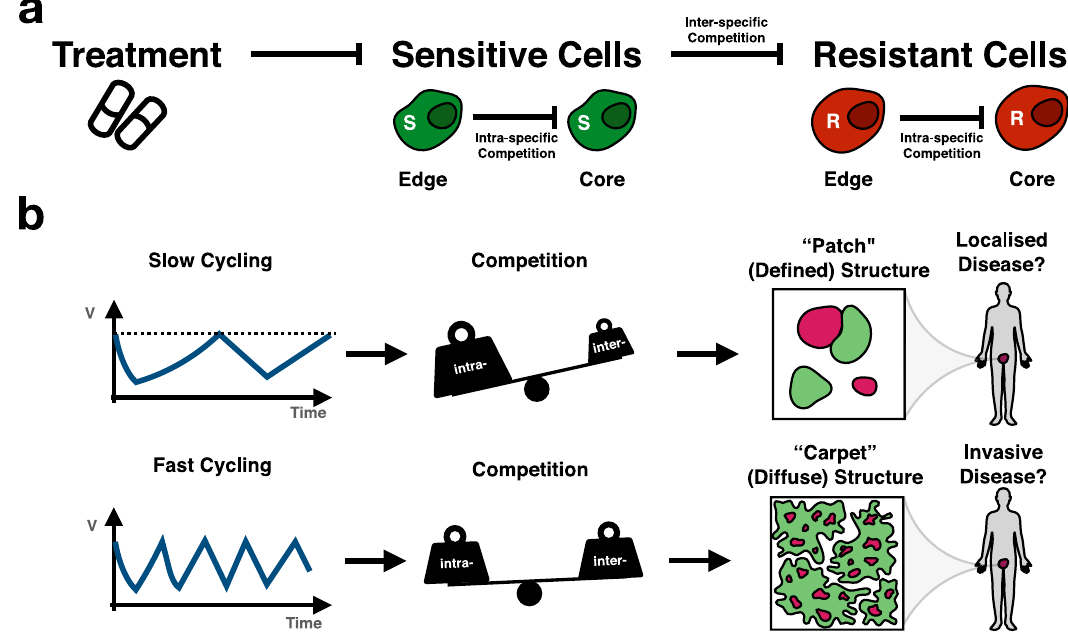
Fig. 8 Paper summary: the tumour ’ s spatial architecture determines the ratio of intra- to inter-speci fi c competition, and thereby the response dynamics under adaptive therapy. a The current theory around adaptive therapy postulates that it keeps resistant cells in check by inter-speci fi c competition from sensitive cells, which can be controlled via treatment ( 9,11 ; adapted from ref. 32 ). Here, we show that intra-speci fi c competition within each population is a further important factor. b In addition, our analysis suggests that the more diffusely growing a tumour, the greater the fraction of inter- speci fi c competition. In addition, this may be re fl ected in faster cycling frequency under intermittent treatment. Going forward, we propose that incorporating knowledge of the tumour ’ s spatial architecture and resulting competition structure will help to design more effective adaptive therapy